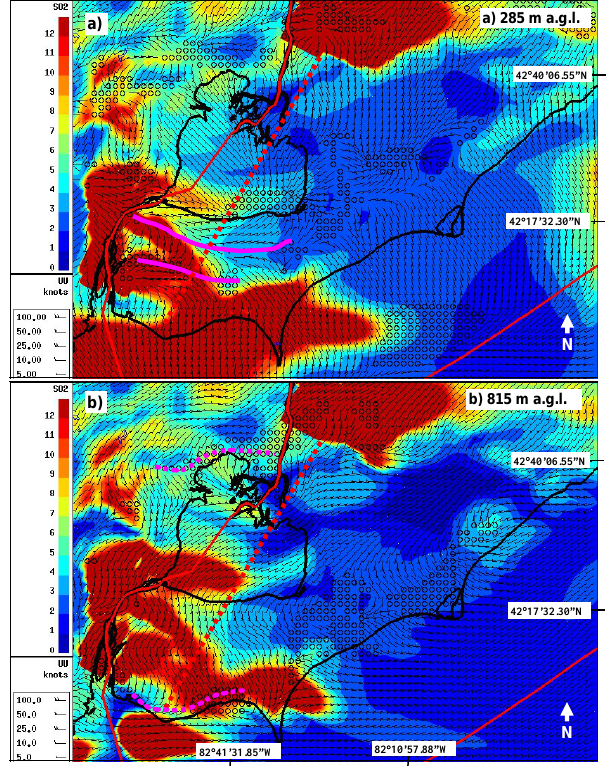
Fig. 7. Model-predicted SO 2 mixing ratios overlaid with wind di- rection at (a) 285ma.g.l. and (a) 815ma.g.l at 12:00LT. Solid ma- genta line indicates surface convergence at the LE and LSC lake breeze fronts and dashed magenta line indicates divergence flow aloft. Dashed red line is the aircraft transect.